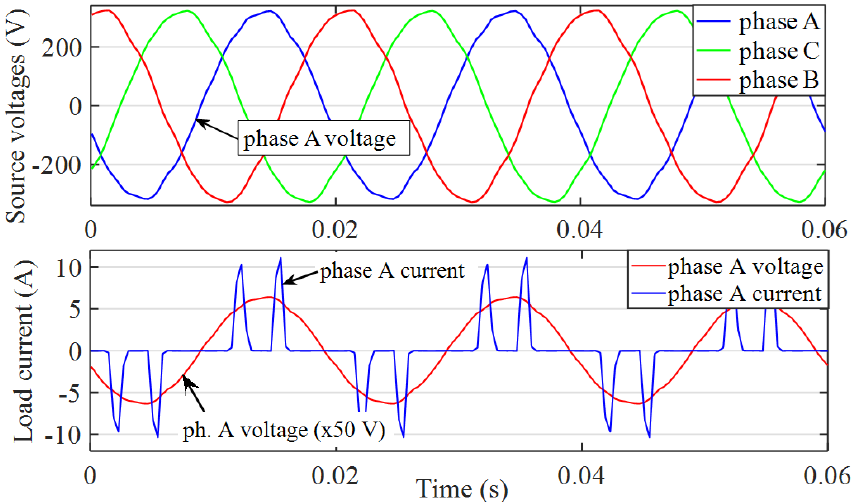
Figure 14. Supply source voltages and phase load current of the experimental three-phase laboratory setup. Up: source voltages showing some distortion and unbalance. Down: voltage and load current by one of the phases, where the current waveform is highly distorted.